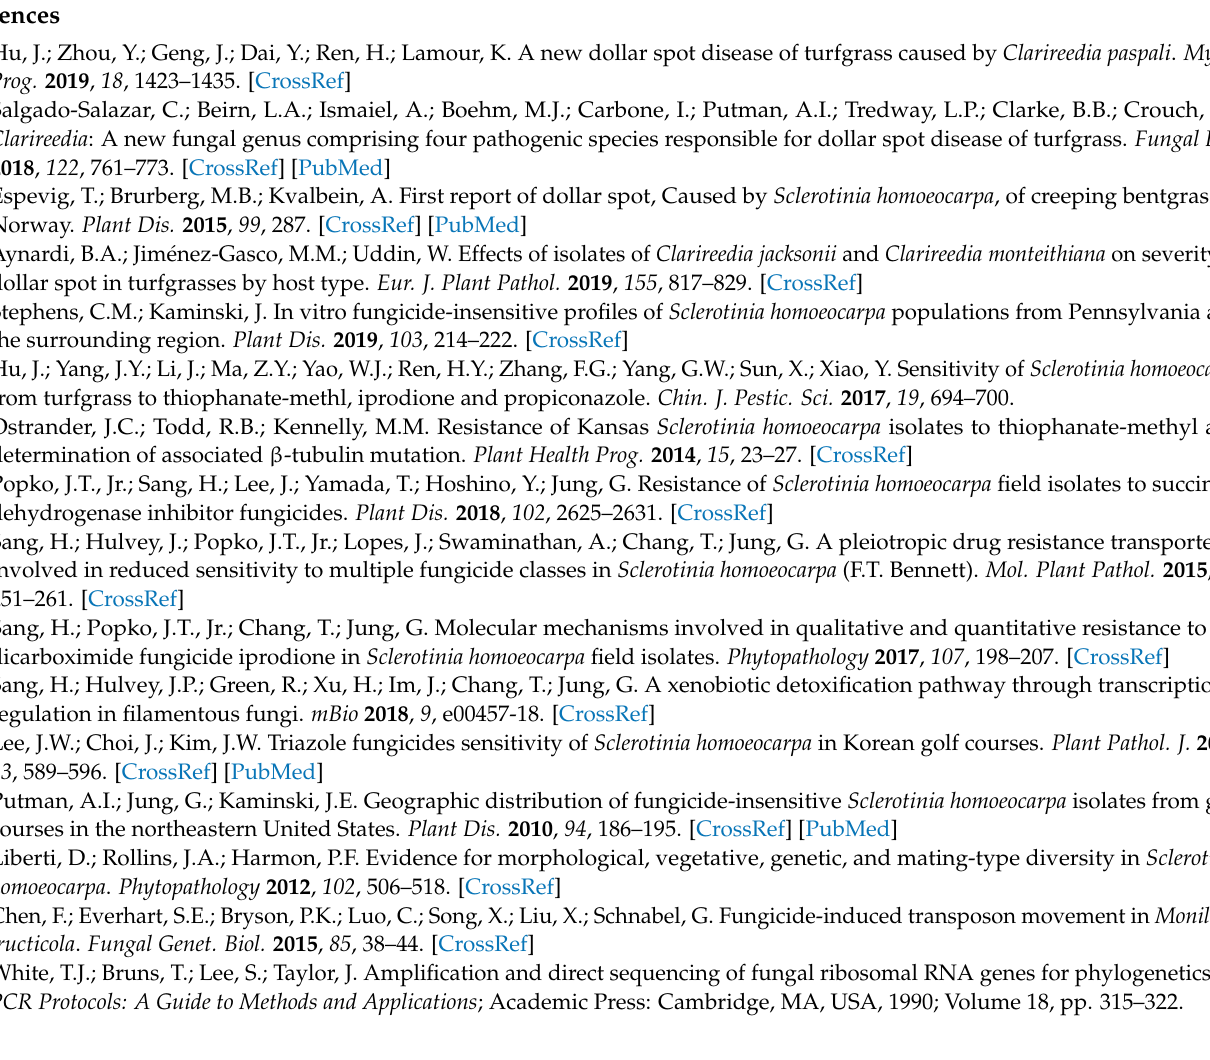
Table S2: In vitro fungicide sensitivity profiles of the three Clarireedia species from different